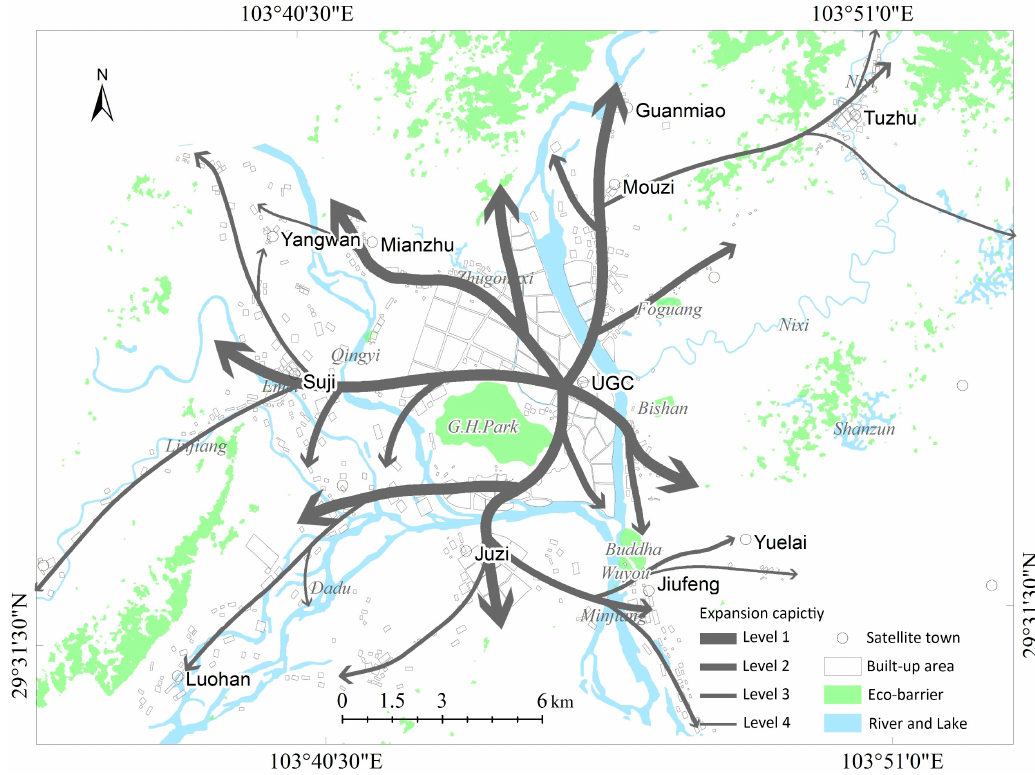
Figure 10. Directions and paths of urban expansion in LS.